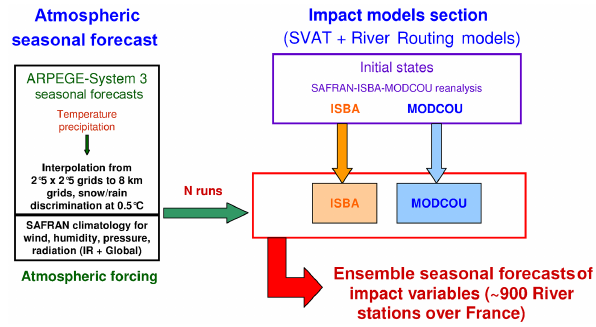
Figure 2. The seasonal hydrological forecast suite used to produce riverflow